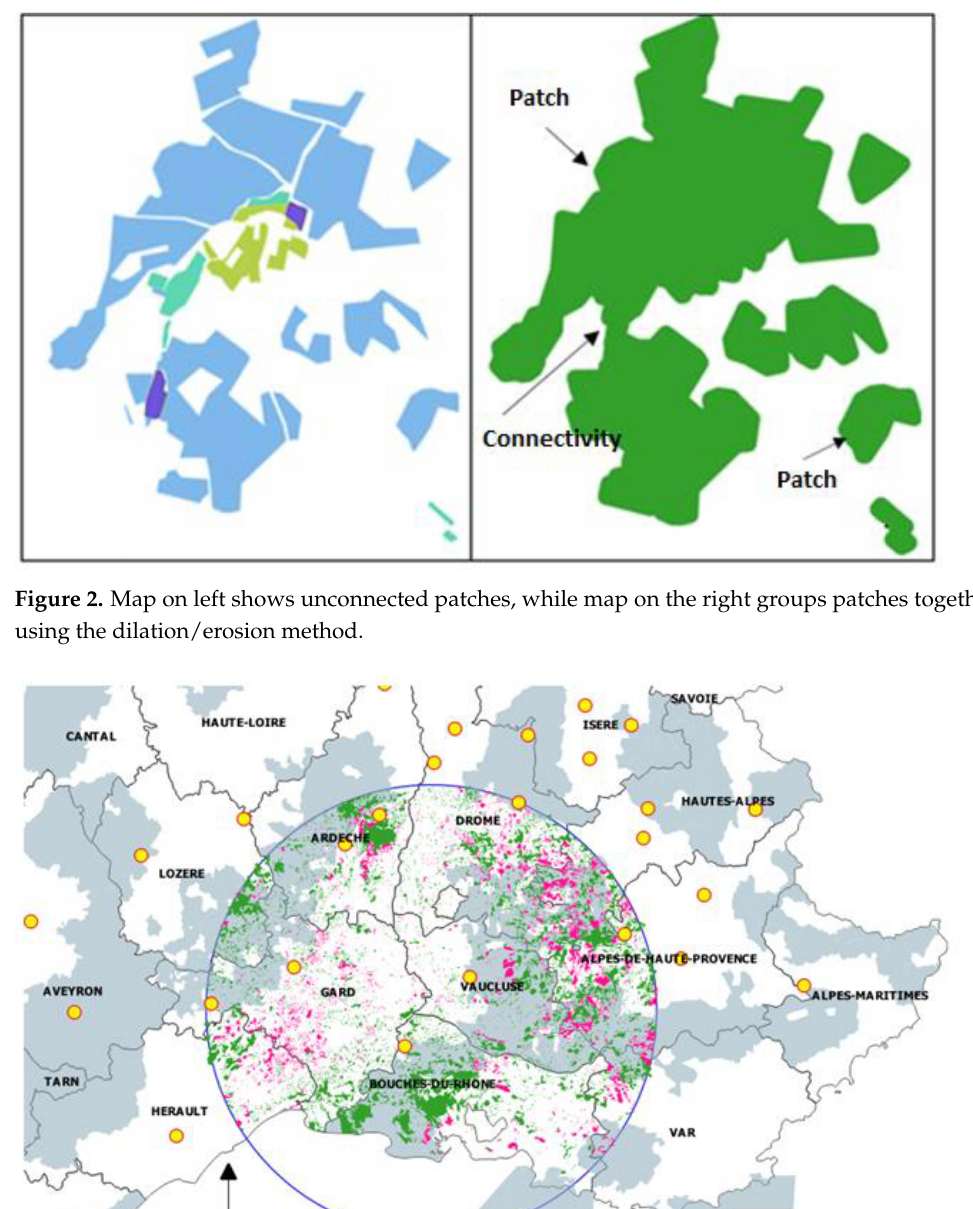
Figure 3. Location of the beef feeding patches within a 100 km radius around the city of Avignon.